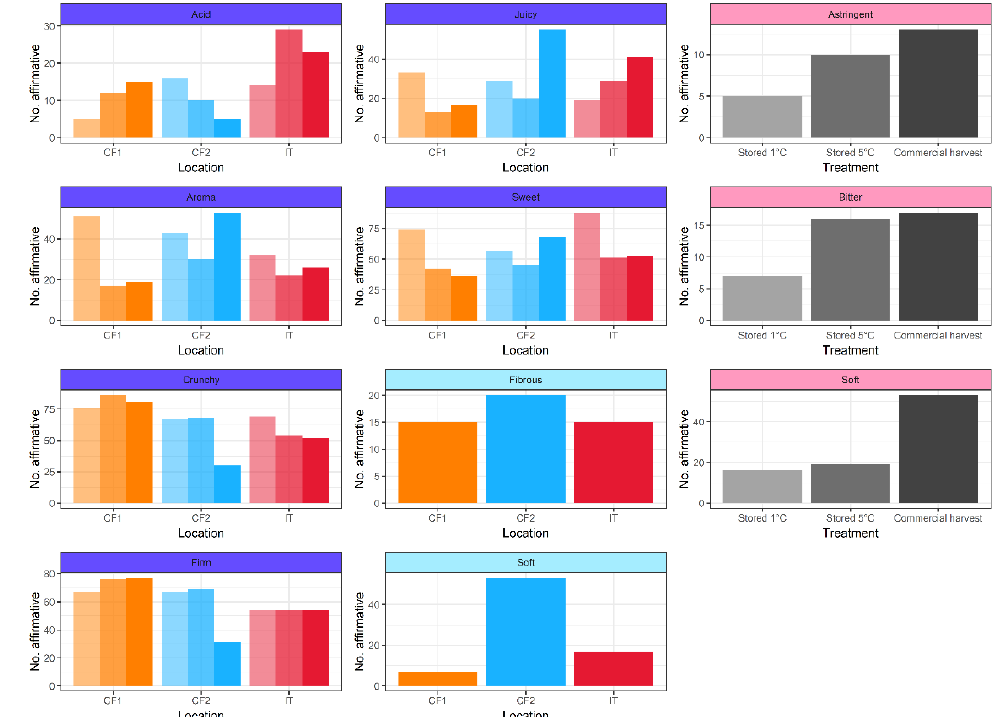
Figure 7. Influence of treatment and location on perceptions of peach characteristics. Sites are coded by colour of the bars (orange = IT, blue = CF1, red = CF2); treatments are coded by shading (light = seven days’ storage at 1 °C, intermediate = seven days’ storage at 5 °C; dark = commercial harvest stage). The colour of the facet bar indicates the result of the manyglm model: purple = significant interaction between site and treatment, blue = significant effect of site, pink = significant effect of treatment.